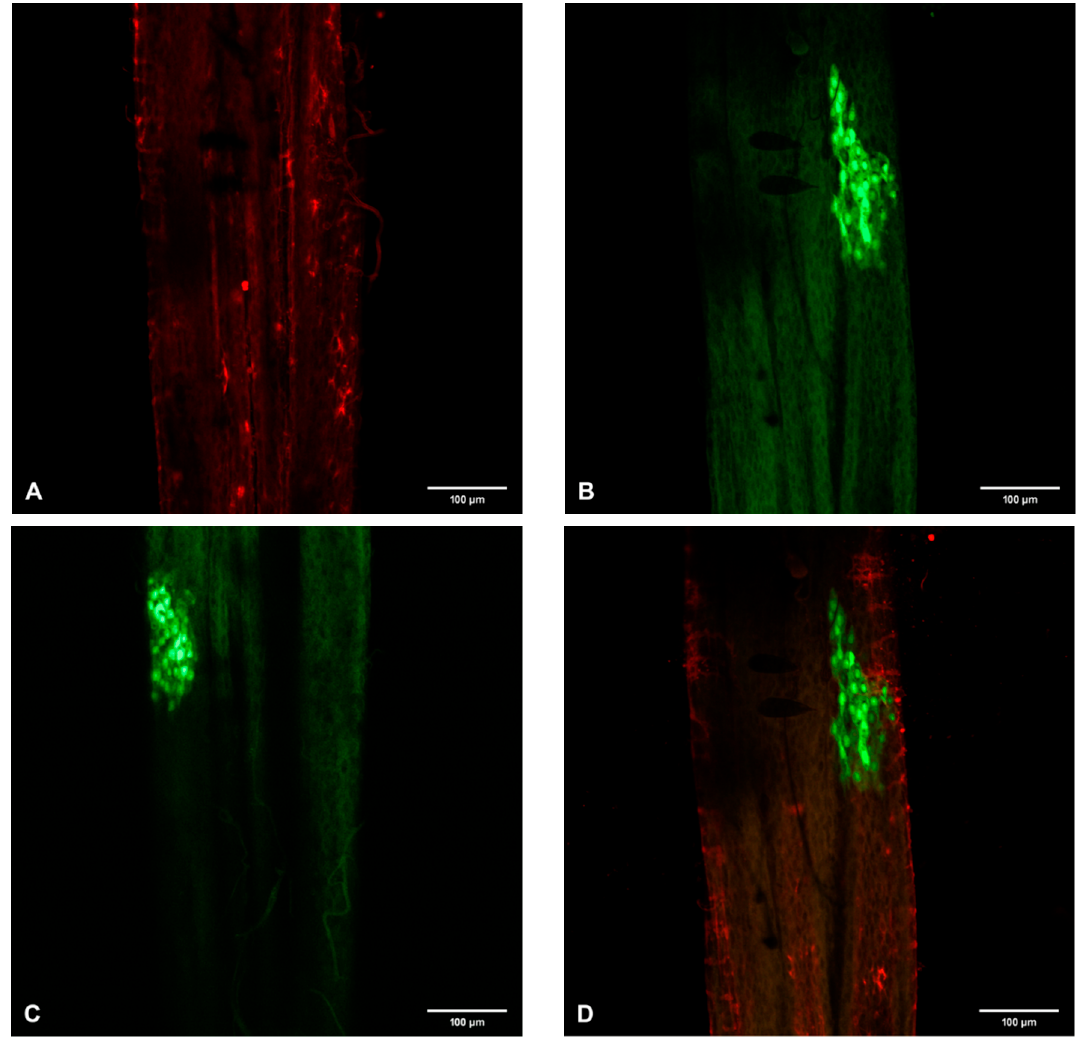
Figure 4. ( A ) Fluorescent laser confocal images of TX-Red FMRFamide positive ECs and ( B , C ) sequential images of a SINV-GFP (green) foci extending from front to back of the MG. ( D ) Overlay image of the GFP infection foci (B) and TX-red stained EC image (A) results in merged image. Midgut of a female Ae. aegypti dissected on day 5 p.i. and GFP SINV infection focus did not colocalize with FMRFamide-positive ECs. 200×.